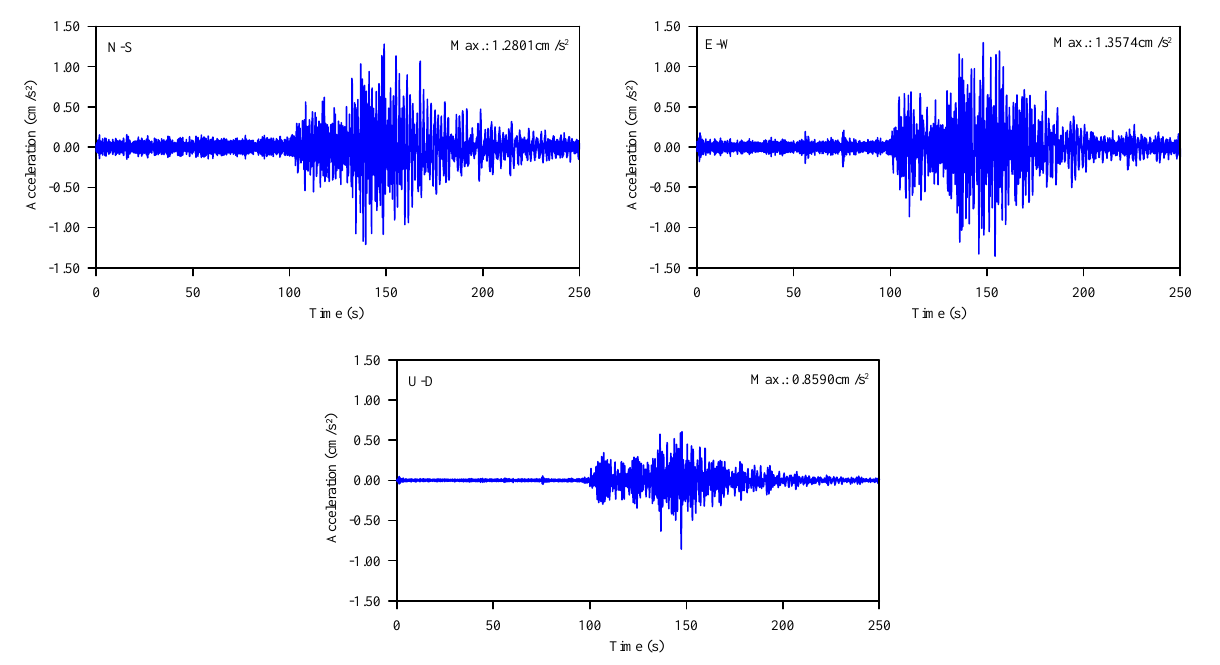
Fig. 5. Acceleration records of Bala (Ankara) Earthquake on 27 December